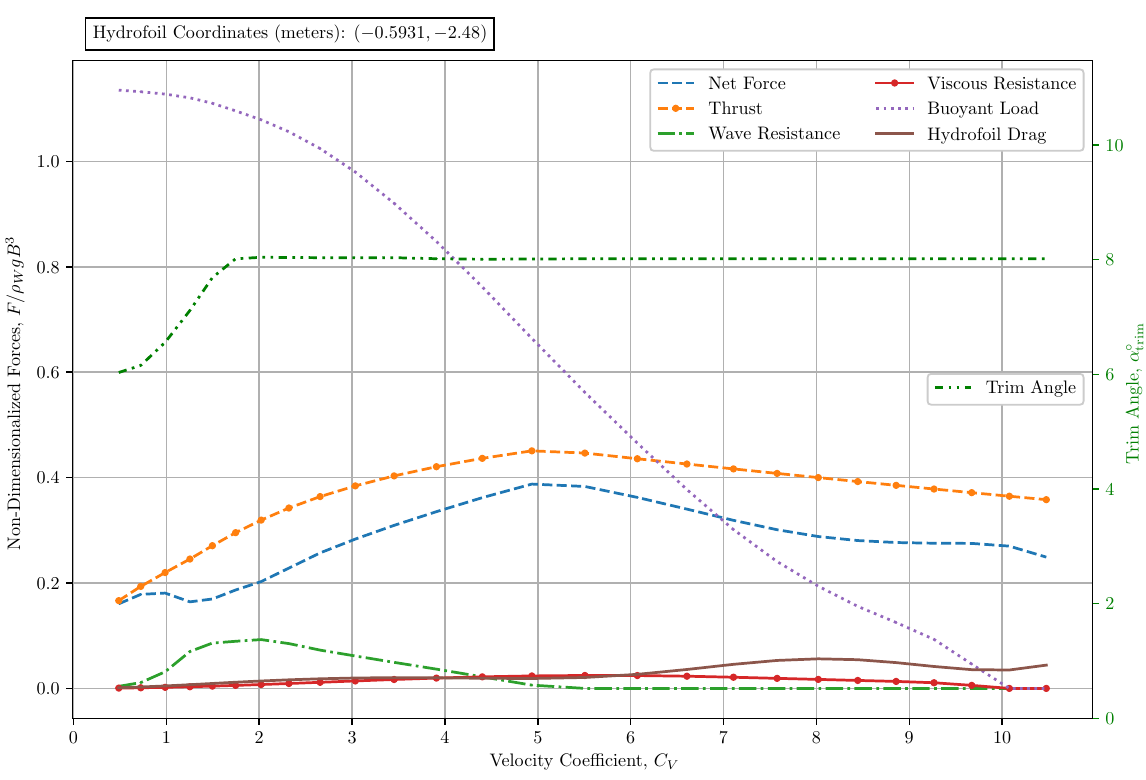
Figure 17. Variations of hydrodynamic and propulsive forces during water-takeoff